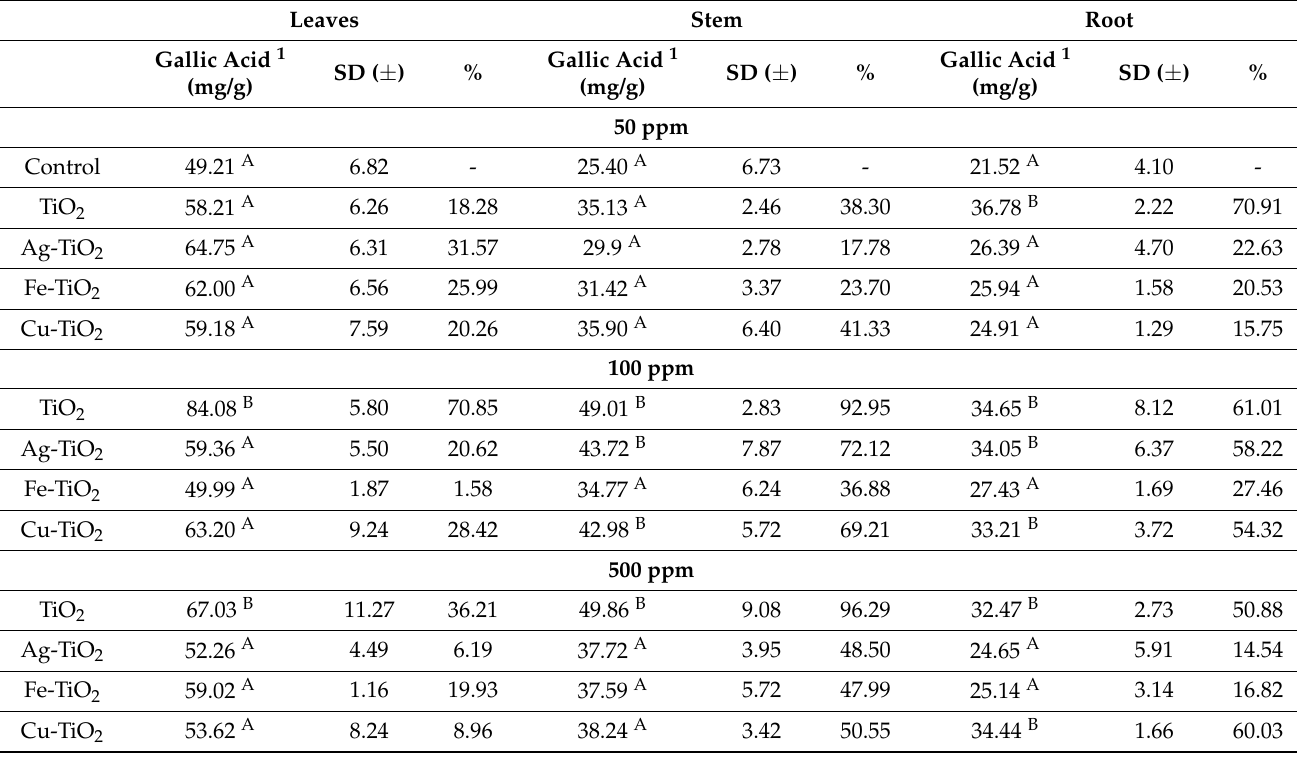
Table 2. Total phenol content in plants treated with SG